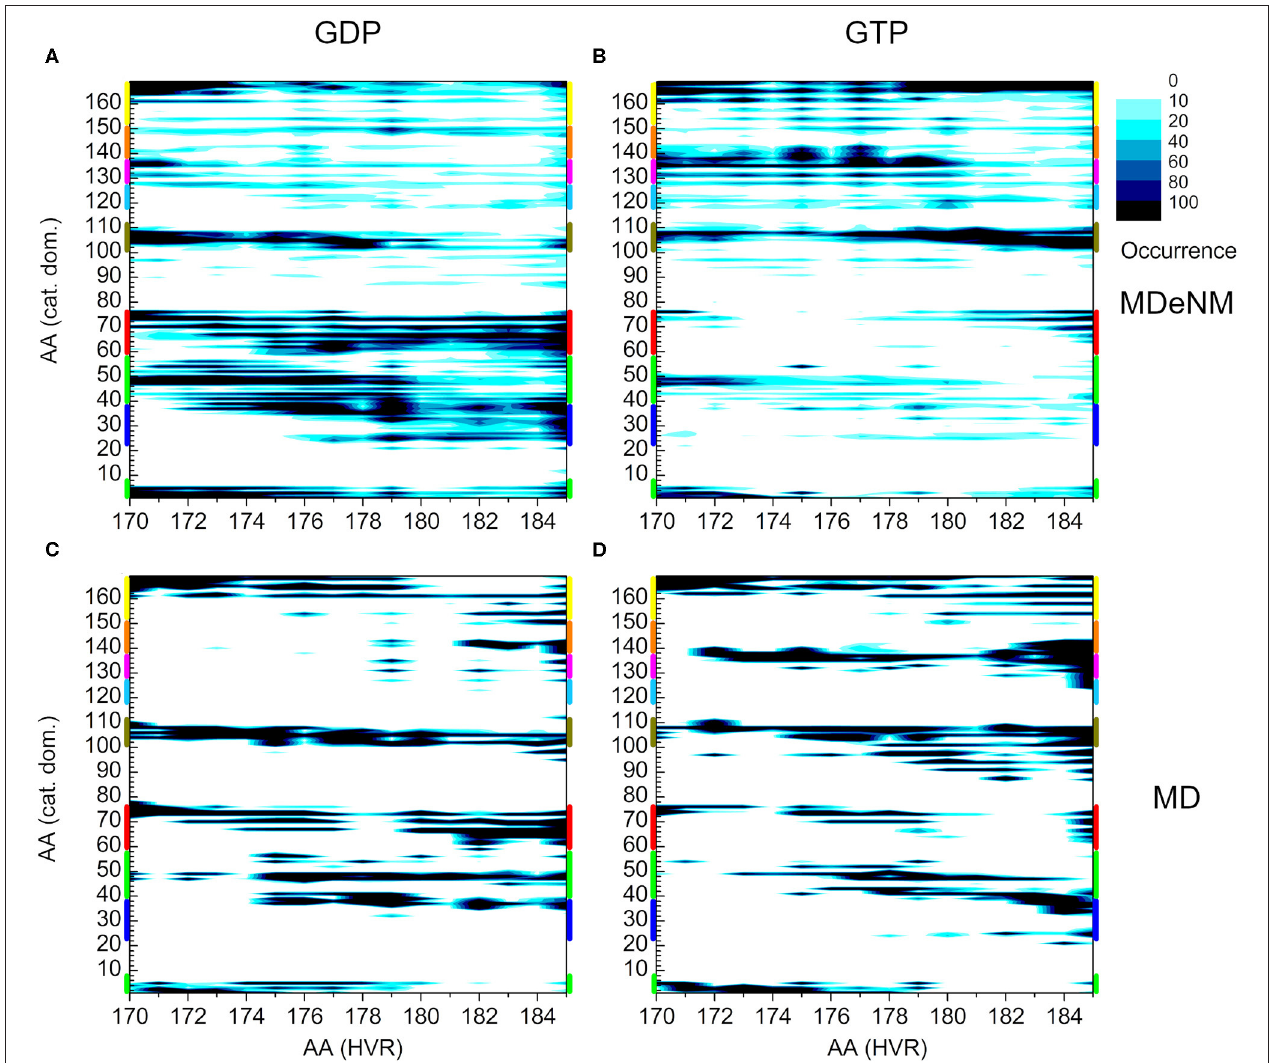
FIGURE 8 | Distance-based interaction map between the catalytic domain and the HVR of K-Ras4B. (A) and (B) correspond to conformations of MDeNM for the GDP- and GTP-bound population, respectively. (C) and (D) correspond to conformations of MD for the GDP- and GTP-bound state, respectively. The color-coding of the structural regions within the catalytic domain along the y-axis is identical to Figure 2